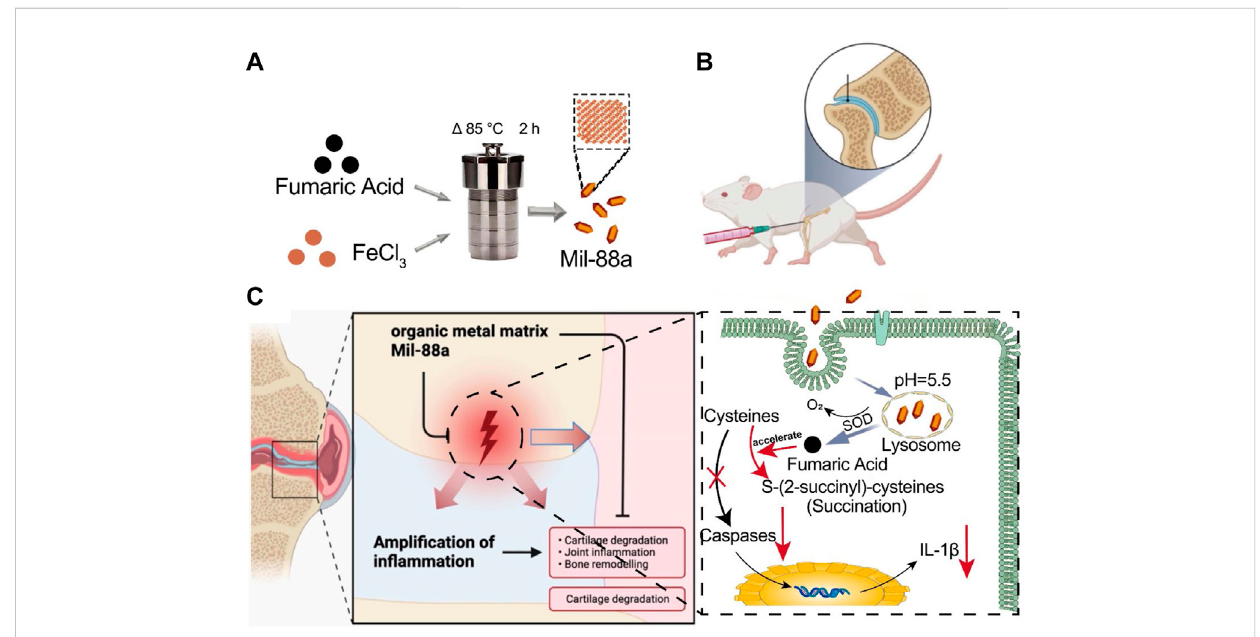
FIGURE 5 Schematicof howMil-88a could improve OAin amousemodel. (A) Flow diagram of the prepared Mil-88a. (B) Illustrationof the injected method of Mil-88a. (C) The treatment process for suppressing the expression of IL-1 β and relief of in fl ammatory